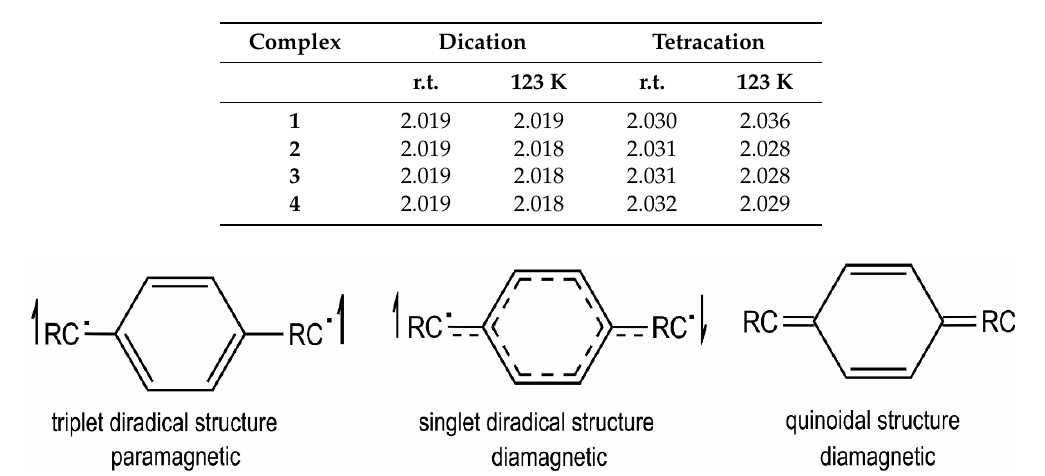
Figure 11. Possible structures and spin multiplicities for compounds with two paramagnetic redox centers RC • bridged by a para ‐ phenylene spacer.